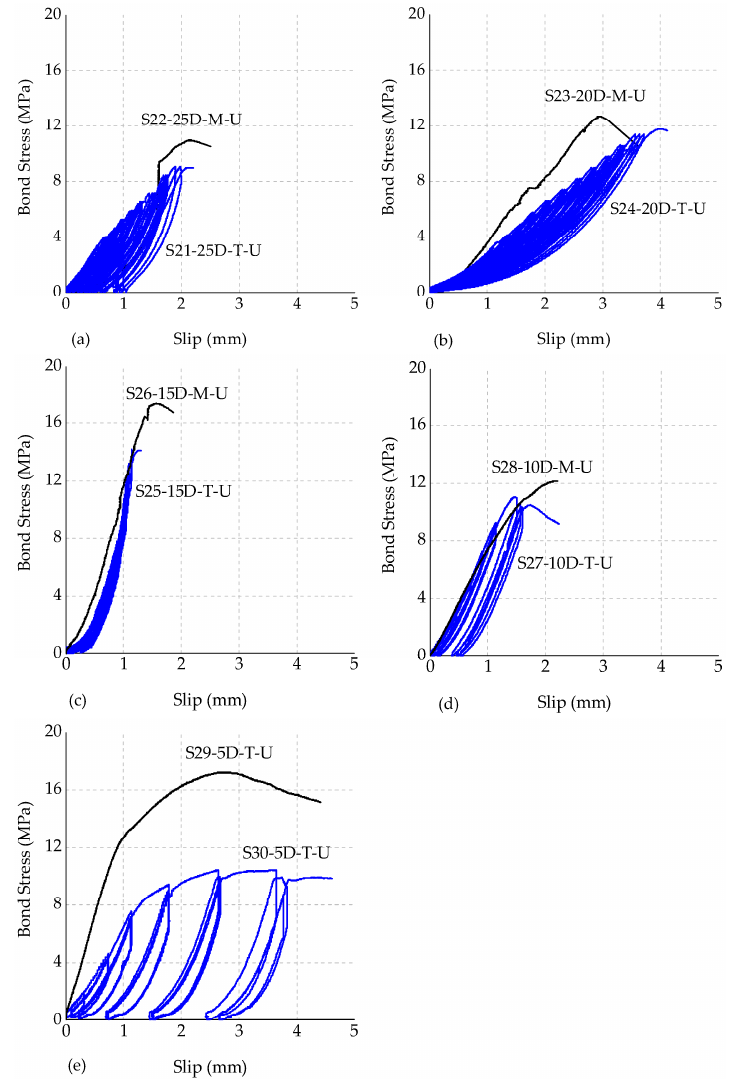
Figure 8. Experimental bond stress versus slip curves. ( a ) 25 d; ( b ) 20 d; ( c ) 15 d; ( d ) 10 d; ( e ) 5 d. Bond stress (in MPa) versus slip (in mm) graphs are plotted and illustrated in Figure 8. It